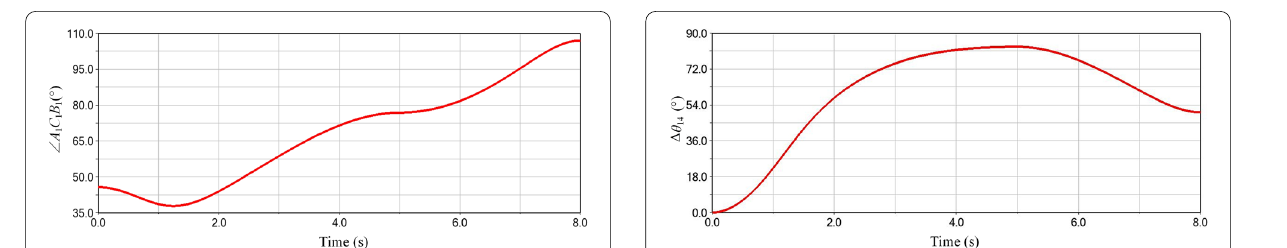
Figure 23 The variation of θ 14 when the mechanism avoids singular position 1